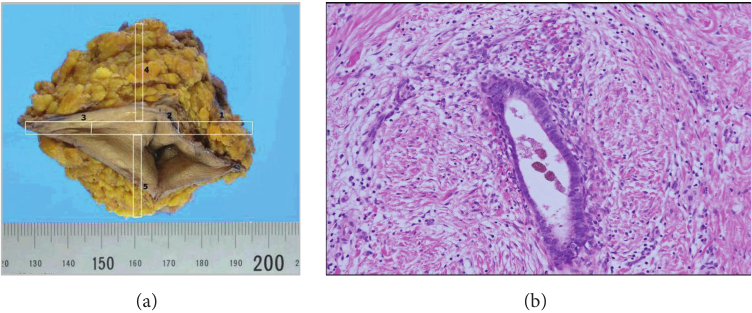
Figure 3: (a) Excised specimen of the umbilicus with surrounded tissue. (b) Histological microscopic view of this lesion demonstrated endometrial gland and stroma (H&E staining: ×